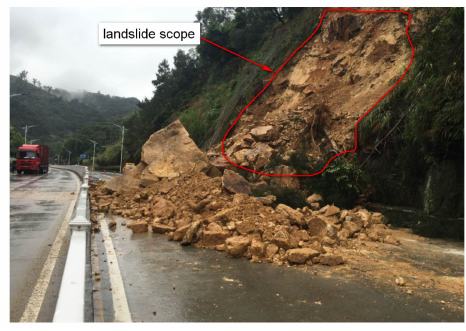
Figure 8. S203 line landslide